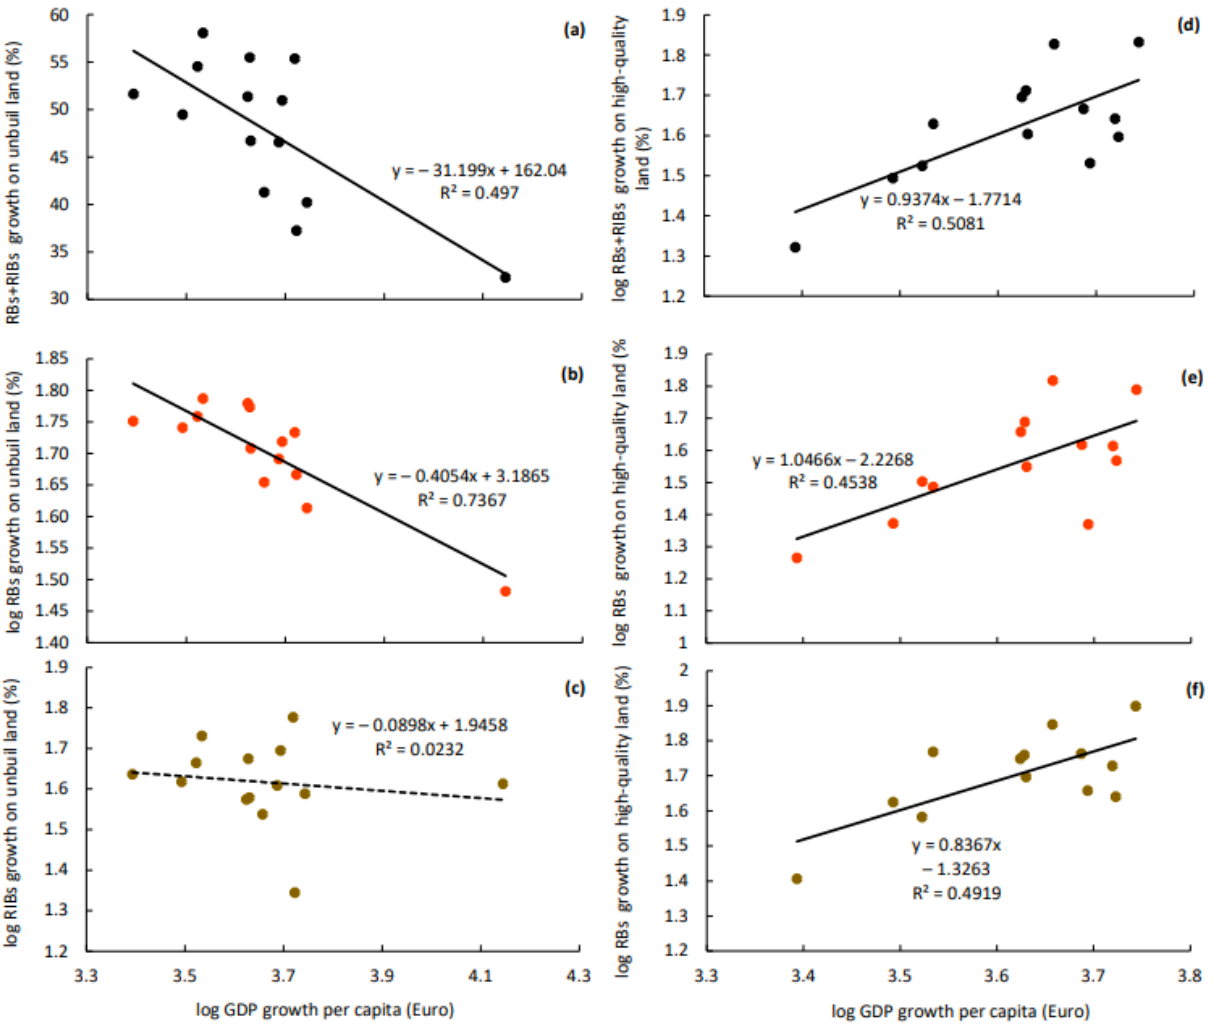
Figure 4. Plots of linear regression analyses showing the relationship between GDP per capita and building growth on undeveloped land ( a-c ) and high-quality land ( d-f ). The dashed line in the trend line represents a statistically insignificant (on p ≤ 0.05) result ( c